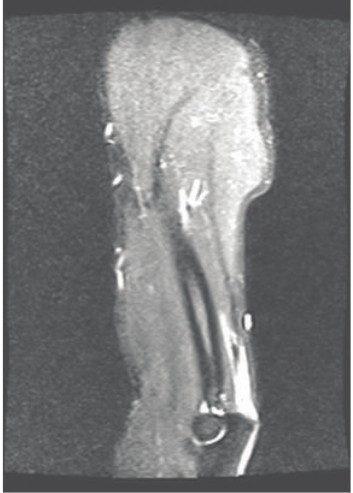
Figure 2: Same elbow, di ff erent view.